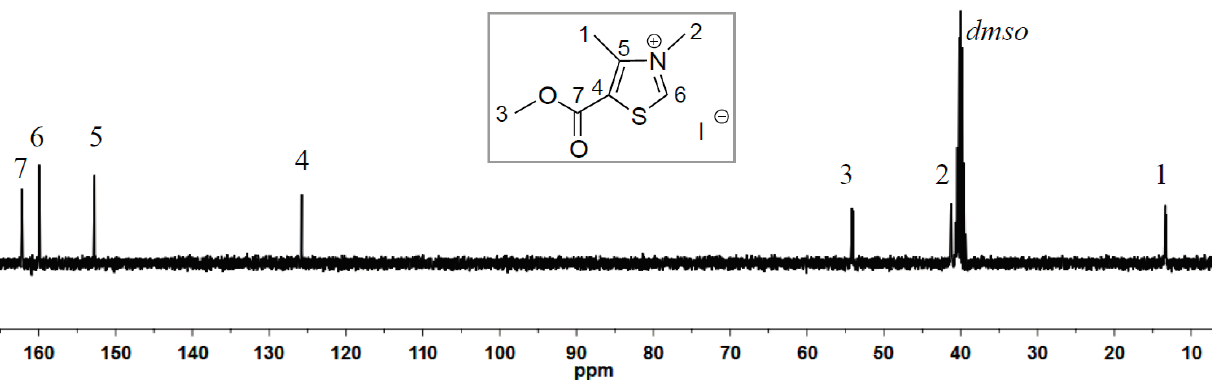
Figure 4. 13 C NMR (DMSO- d 6 ) of Ac